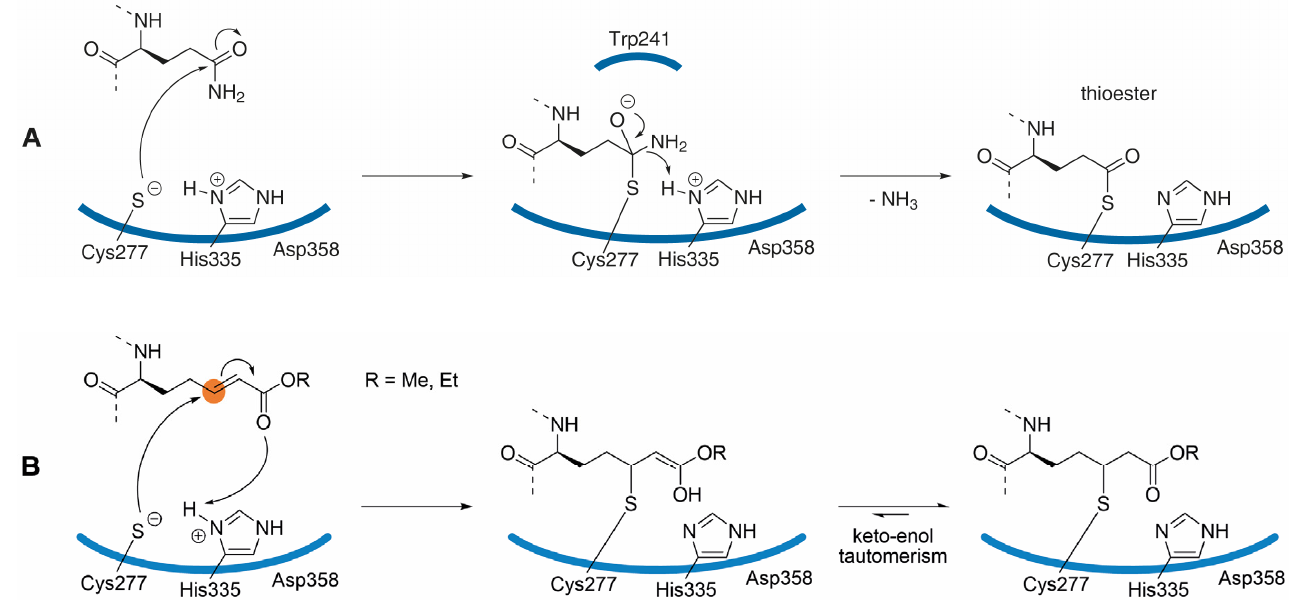
Figure 2. ( A ) Transglutaminase reaction mechanism: the catalytic triad of human tissue transglutami- nase is formed by the amino acids Cys277-His335-Asp358. The proposed thiolate-imidazolium ion pair is exceptionally nucleophilic enabling the attack of the otherwise inert carboxamide side-chain of protein bound glutamine to yield the thioester intermediate that itself is prone to react with the ε -amino group of lysine (not shown). The proposed tetrahedral oxyanion is stabilized by Trp241 and by the backbone nitrogen of Cys277; the driving force of the reaction is the release of ammonia. Hydrolysis of the reactive thioester is suppressed by the narrow hydrophobic tunnel excluding water from the catalytic site [48]. ( B ) The Michael acceptor warhead mimics the substrate glutamine side- chain, and when embedded in a suitable peptidic/peptidomimetic backbone the warhead addresses the catalytic center of tissue transglutaminase. The cysteinyl γ thiolate moiety of Cys277 attacks the complementary electrophilic β -carbon (marked in orange) of the α , β -unsaturated ester. The Michael addition to the alkene leads to the covalent, irreversible inhibition of TG2, following the mechanism previously described for cysteine proteases